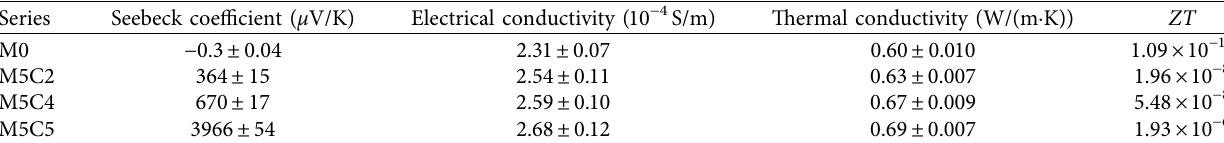
Table 4: The Seebeck coefficient, electrical conductivity, thermal conductivity, and average ZT of different series of cement composites. Series Seebeck coefficient ( μ V/K) Electrical conductivity (10 − 4 S/m) Thermal conductivity (W/(m ·